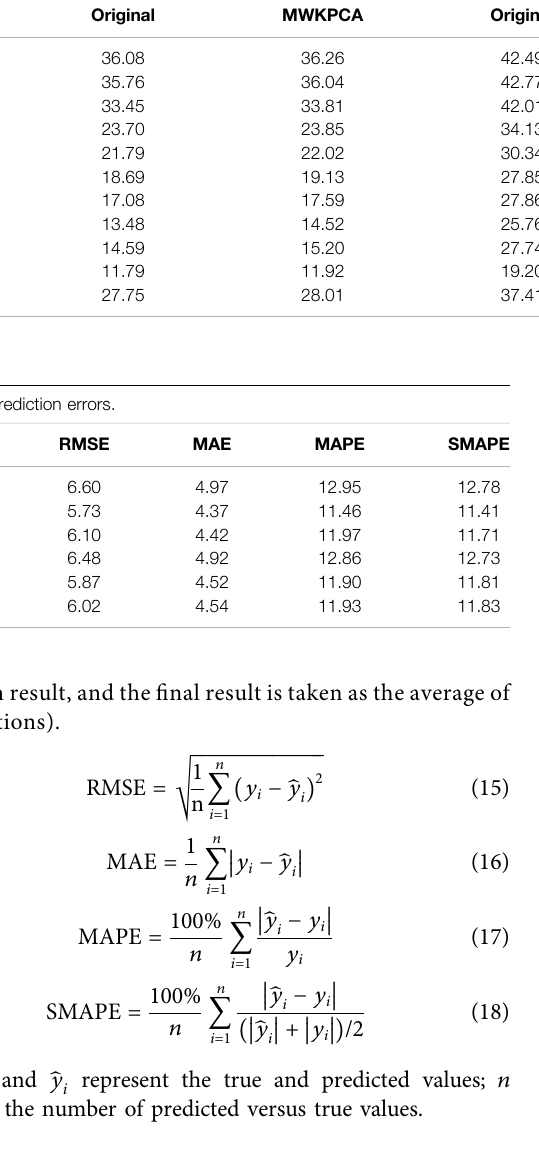
TABLE 1 | Statistical values of audible noise (AN) in each frequency band before and after data processing.